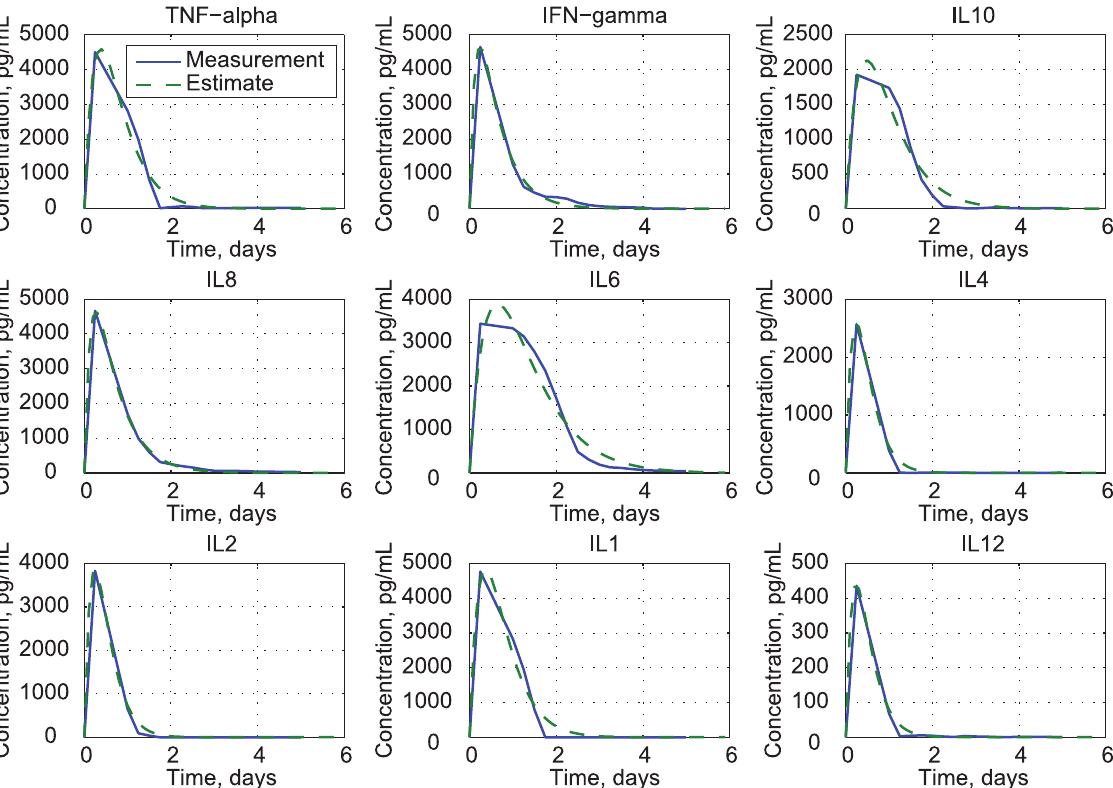
Figure 1. Comparison of clinical trial data [ 11 ] and estimates from uncoupled second-order models of cytokine response.